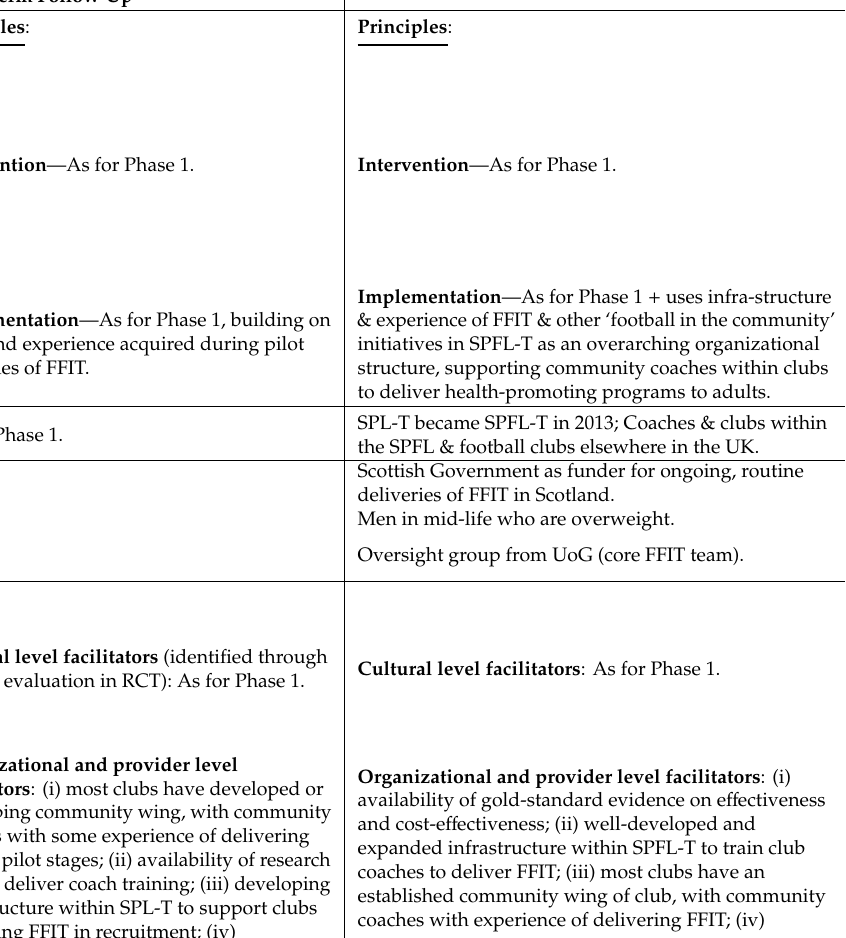
Implementation Phase 1: Program Development, Pilot Deliveries & Pilot Feasibility Trial